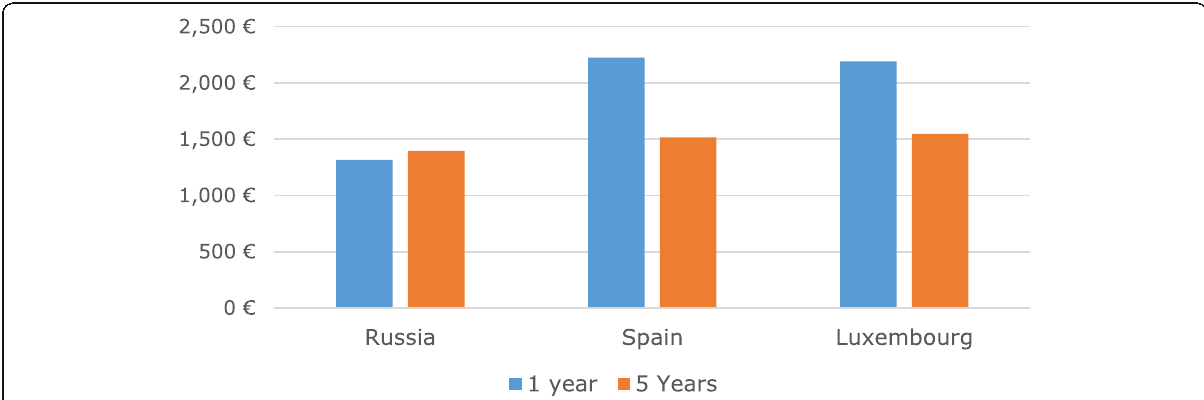
Fig. 2 Economic analysis: Incremental cost-effectiveness ratio (euros spent for each HLY gained) at one year and 5 years, from health-provider perspective (migraine). Note: For tension-type headache and medication-overuse headache, the intervention is not only more cost-effective than current care but also cost saving over 1 and 5 years (see Tables 1, 2 and